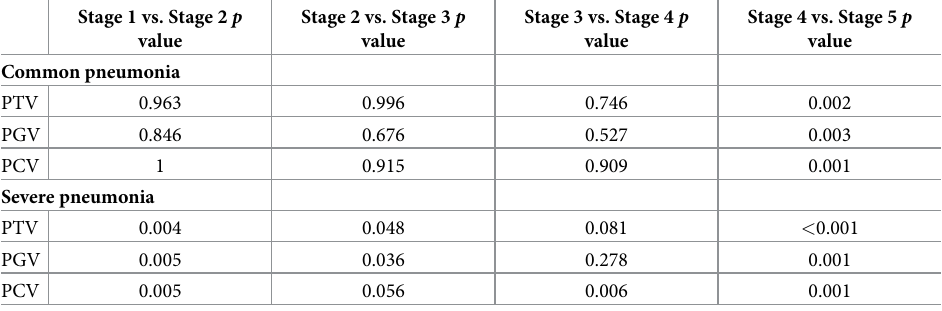
Table 3. Comparison of PTV, PGV and PCV between